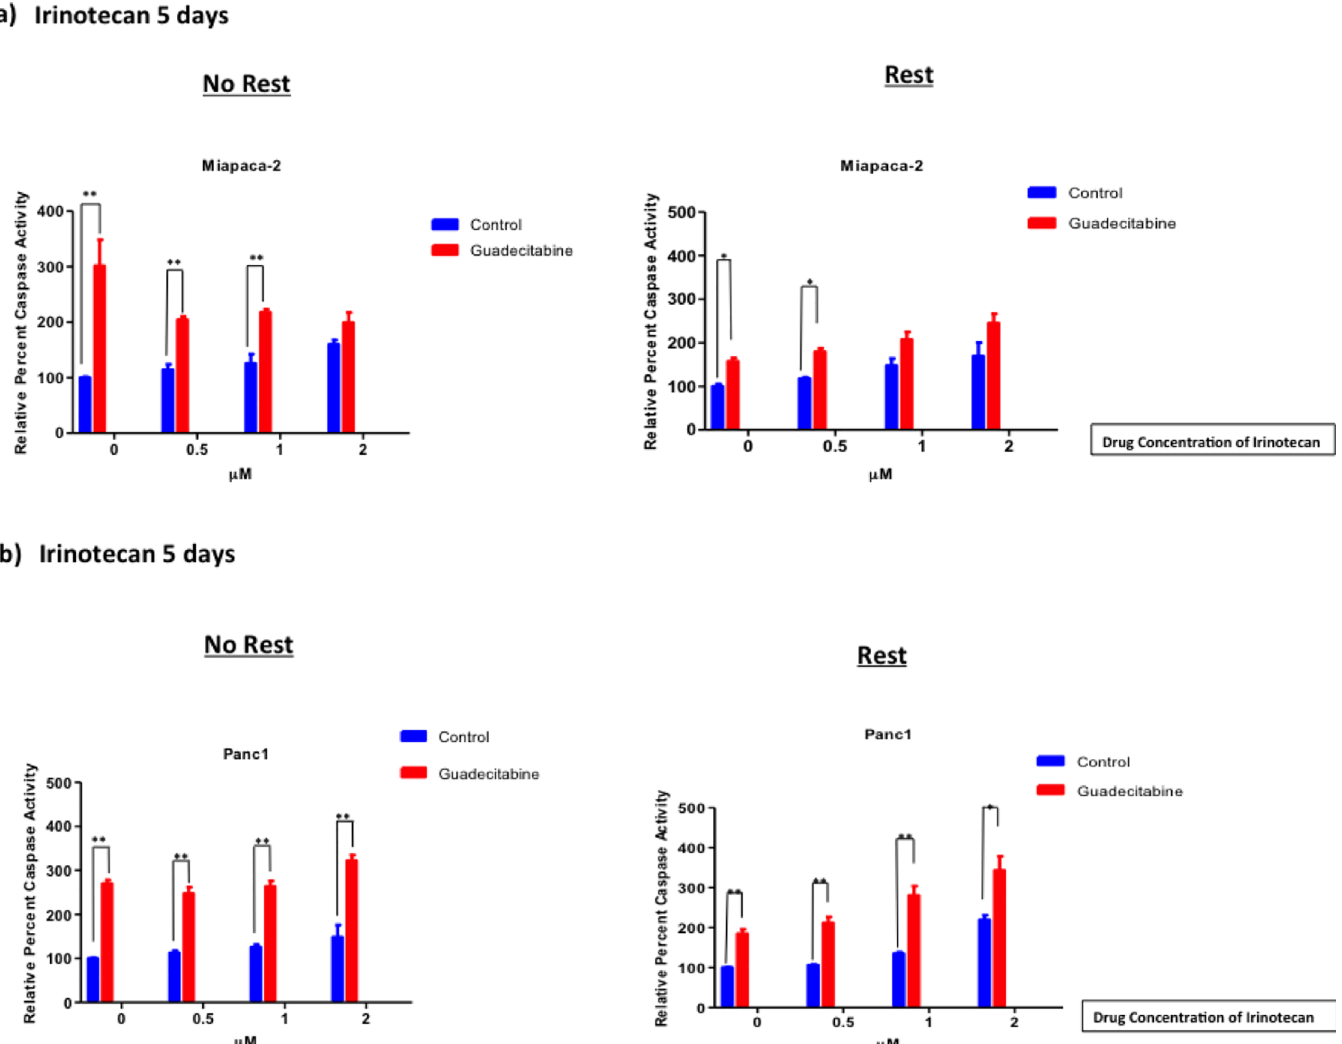
Fig 5. Pre-sensitized cells by guadecitabine upregulated apoptosis. Miapaca-2 (a) and Panc1 (b) cells were pretreated with 0.14x10 -3 μ M of guadecitabine for 3 days. The cells were either treated immediately or given rest for 5 days. Afterwards, the cells were treated with different concentrations of Irinotecan for 5 days. Caspase activity was measured and statistical analyses was done as mentioned earlier. A non-parametric t test was used for statistical analysis. Data shown represents mean ± SEM.